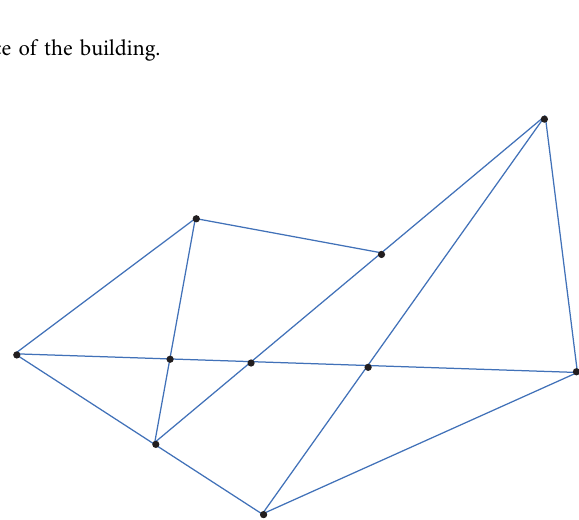
Figure 7: Partitioning diagram of an irregular triangular